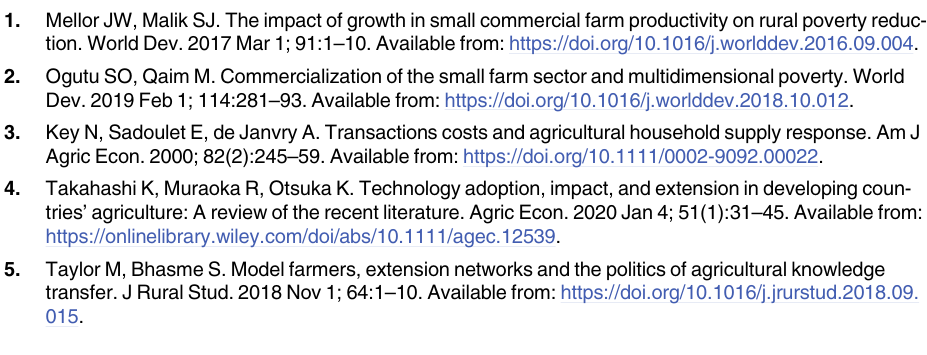
S8 Table. PSM estimates with outcome variables in linear form. S9 Table. Association between adopting digital extension services and agricultural perfor- mance (IPWRA results).